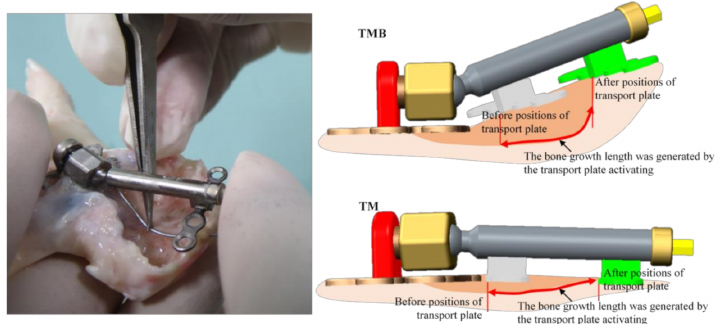
Figure 4. Bone growth total length at the angulus region corresponding to the distractor transport bone plate movement before and after distraction, calculated by measuring the bending steel wire that was attached to the bone growth